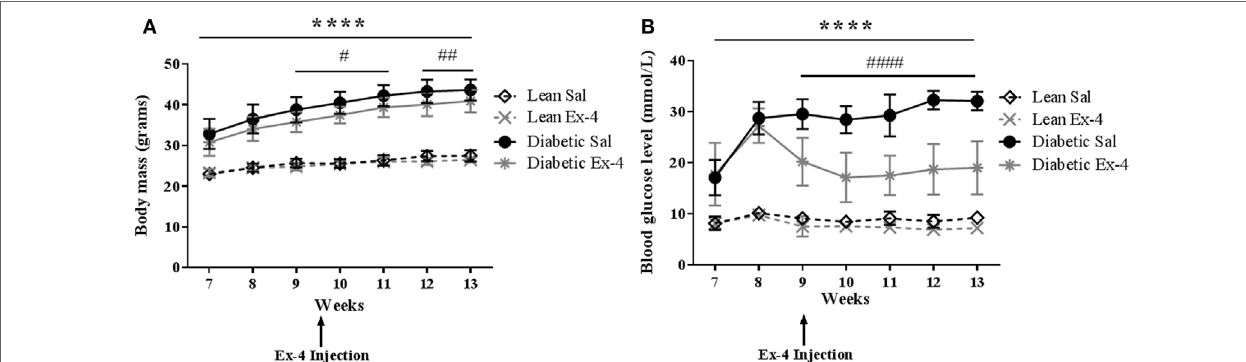
FigUre 1 | Body mass and blood glucose in db/db and control mice. Body mass and blood glucose levels were measured weekly in db/db and lean mice. Injections of Exenatide started at week 9 and continued daily for 4 weeks. (a) Body mass in relation to age in lean, diabetic, and Exenatide-treated mice from 7 to 13 weeks of age. (B) Blood glucose levels in lean, diabetic, and Exenatide-treated mice from 7 to 13 weeks of age. Bars represent mean ± SD for n = 10 mice/ group, **** P < 0.0001 saline-treated diabetic versus saline-treated lean; # P < 0.05; #### P < 0.0001 Exenatide-treated diabetic versus saline-treated diabetic